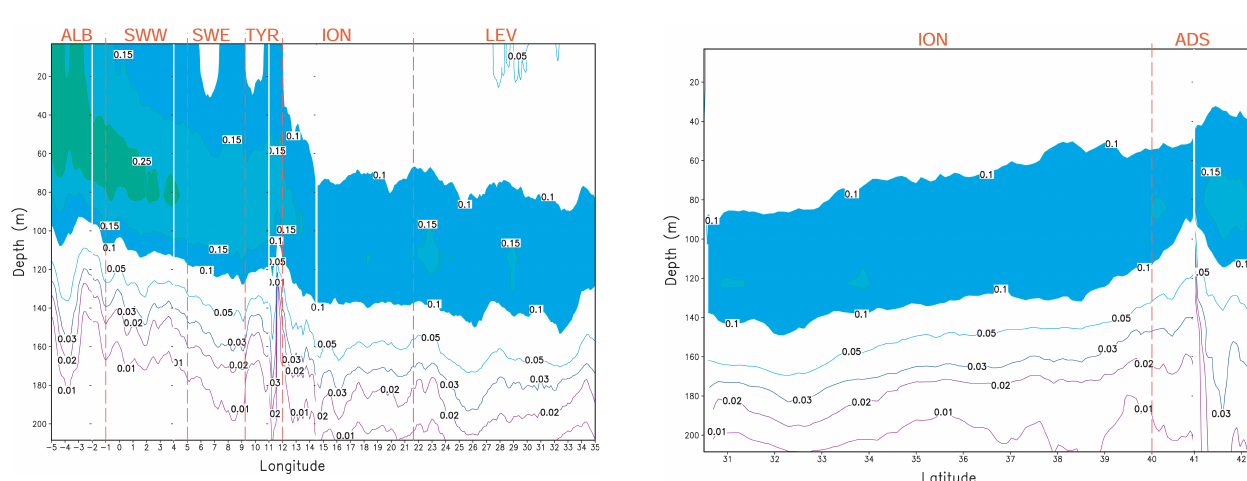
Fig. 4c. Vertical section of average chlorophyll (mgchl- a m − 3 ) from OPATM-BFM REF run along the T3 meridional transect (see Fig. 1) for the period 1999–2004. Crossing lines between transect T3 and regions are indicated by dashed red lines. Table 2. Horizontal averages of vertically integrated net primary productions (gCm − 2 yr − 1 ) for selected model simulations. Data indicate typical mean and (for climatology only) related inter- annual variability, computed as mean and standard deviations of the six annual mean values, respectively. The average of the six stan- dard deviations is reported in parentheses as the typical intra-period variability.